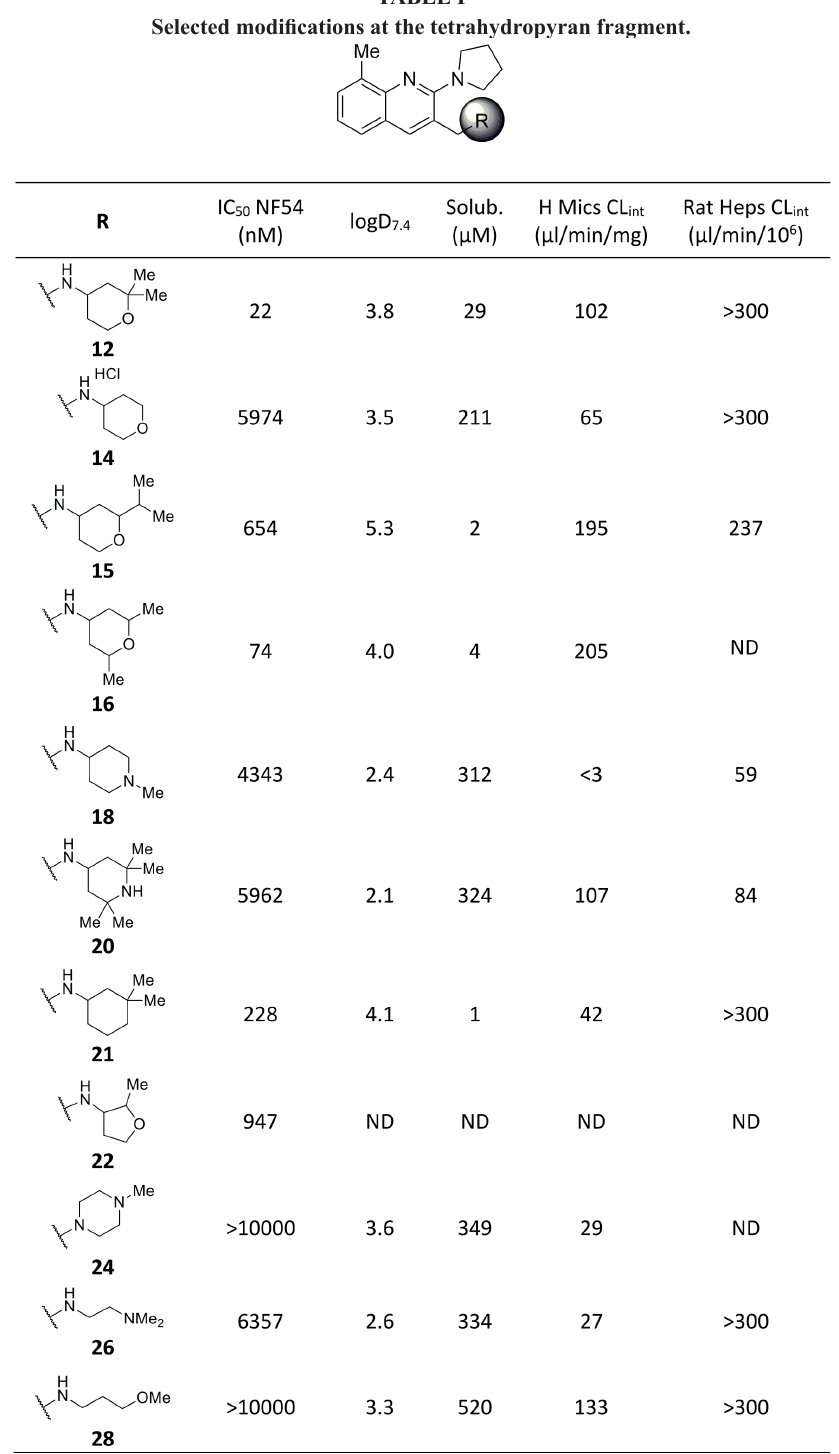
Selected modifications at the tetrahydropyran